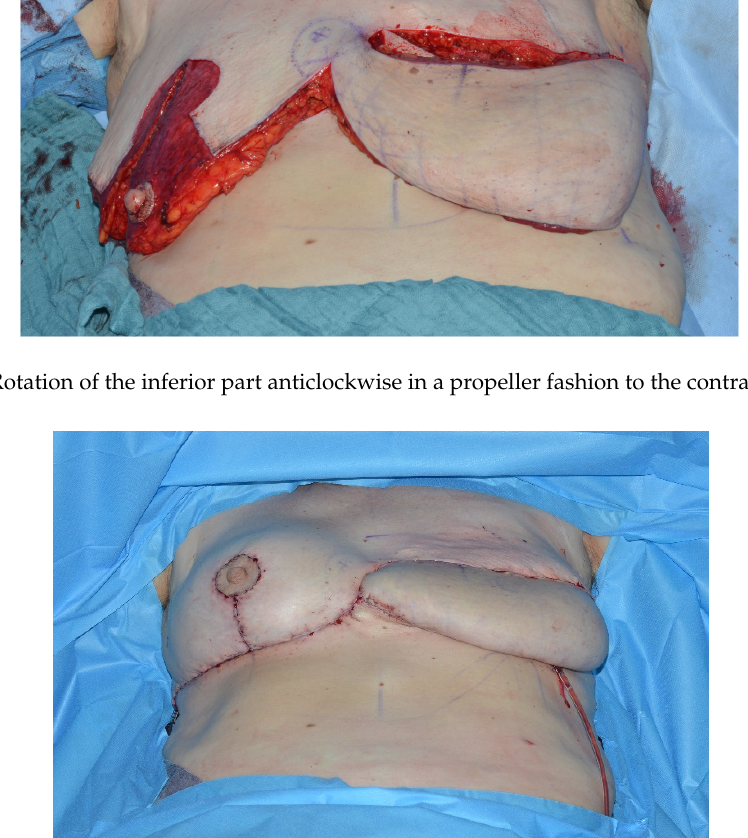
Figure 6. Immediate postoperative result.